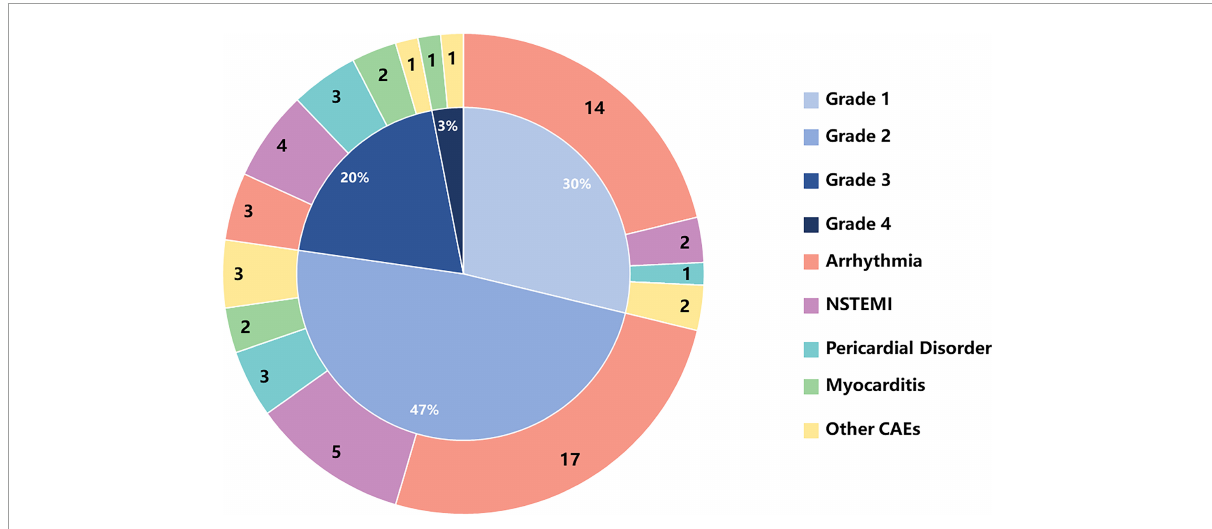
FIGURE2 The numbers of CAEs and percentages of CAE toxicities based on CTCAE grading in cancer patients receiving ICIs. CTCAE, Common Terminology Criteria for Adverse Event; NSTEMI, non-ST-segment elevation myocardial